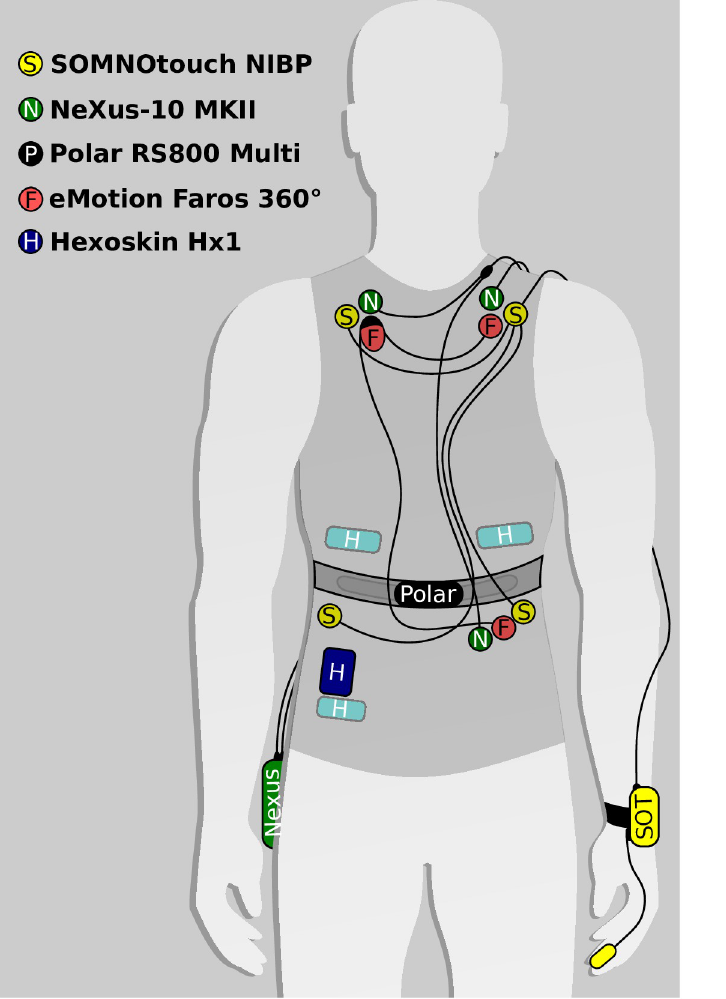
Fig 1. ECG system configuration for simultaneous measurement (adapted from